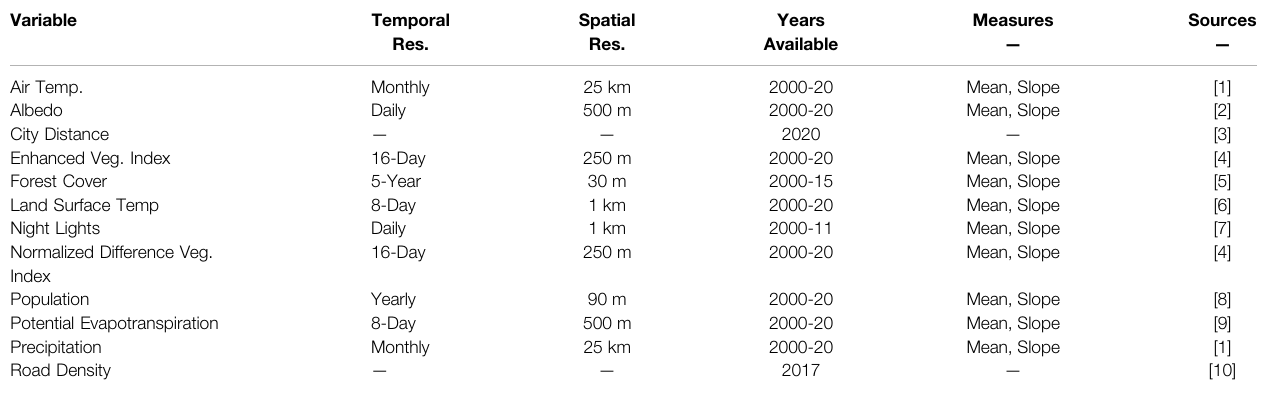
Spatial Years Measures Sources — — Res. Res. Available